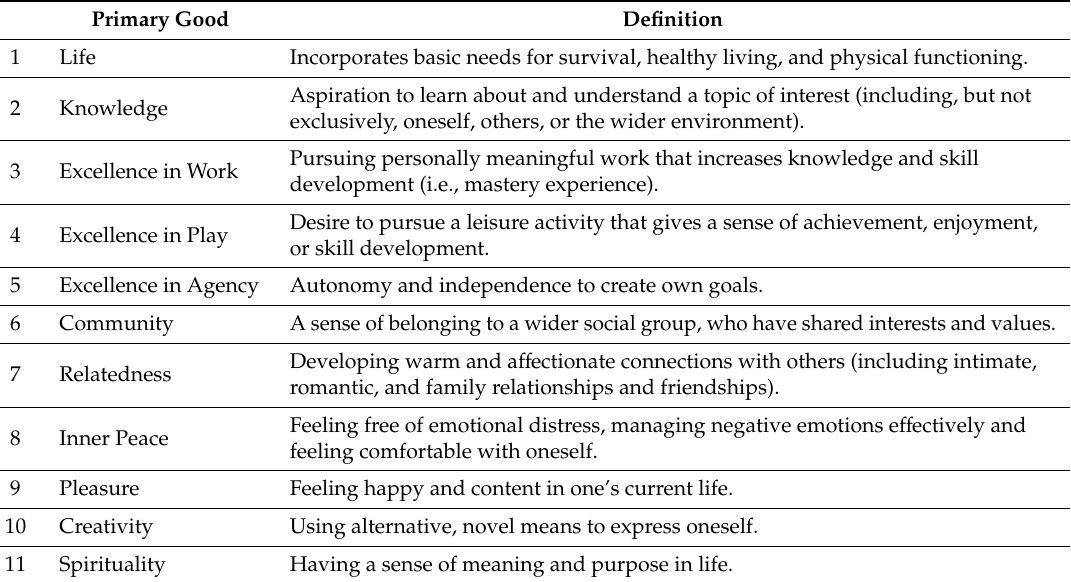
Table 2. Eleven Primary Goods and Definitions (Yates et al.